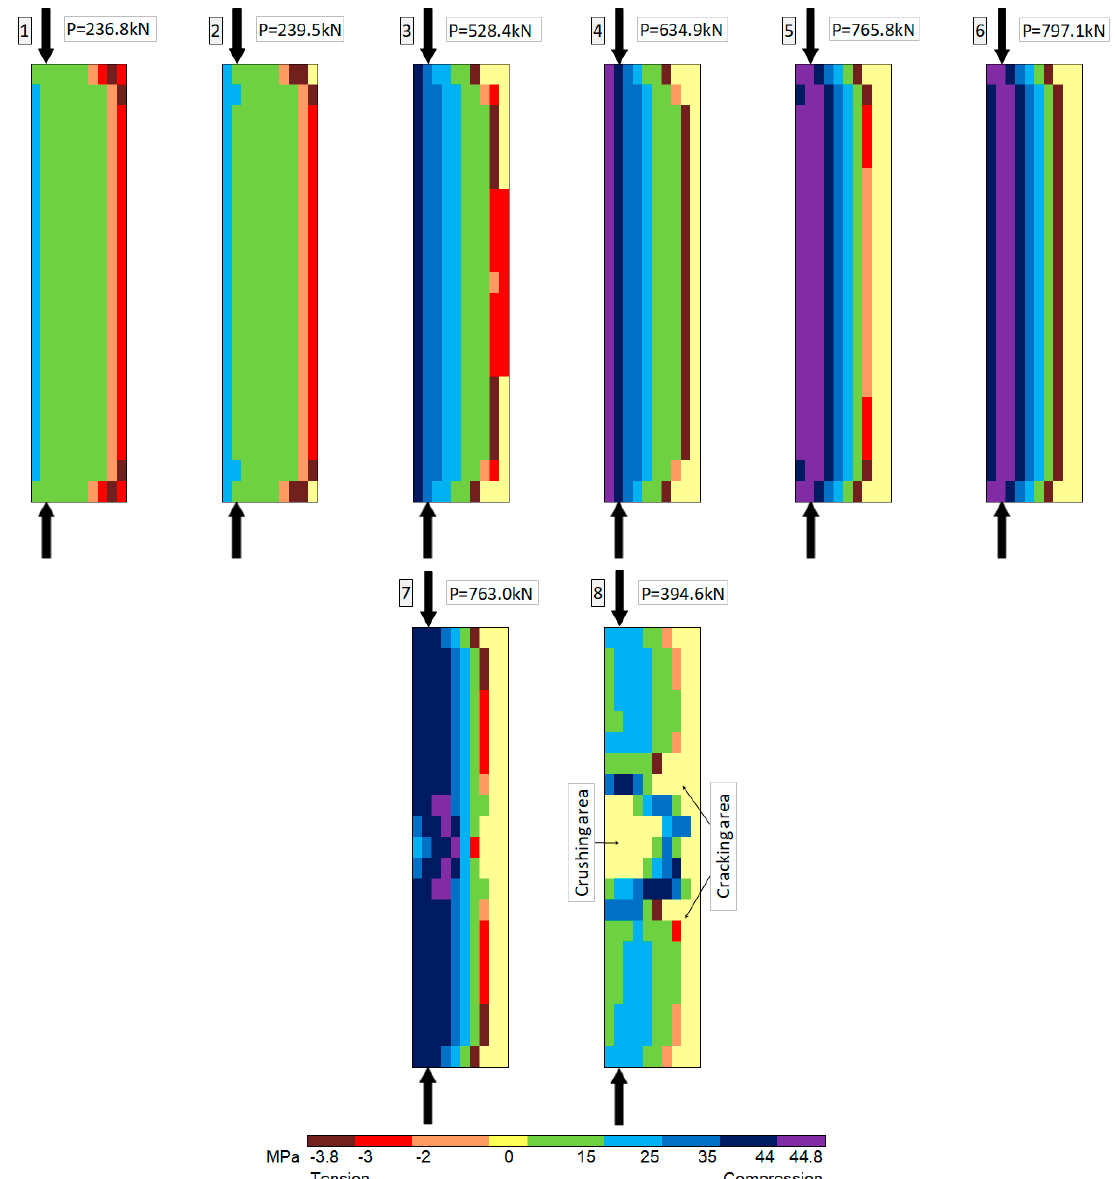
Figure 13. Distribution of normal stresses depending on the load of the column.